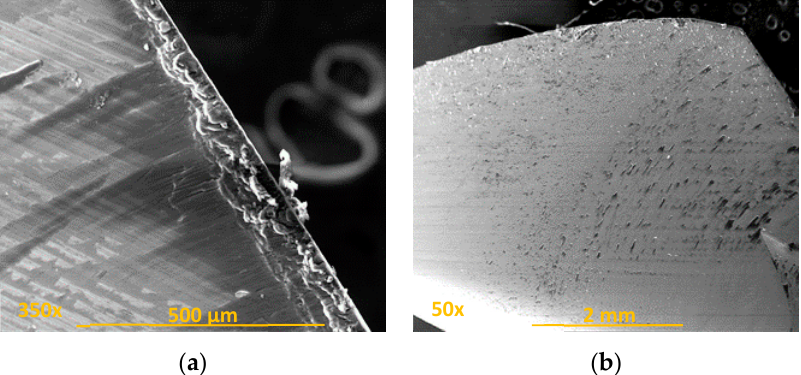
Figure 9. Wear by bonding mechanisms (BUL–BUE) on the tool after conventional drilling of the aluminium alloy UNS A97075: ( a ) Main cutting edge; ( b ) evacuation channel.